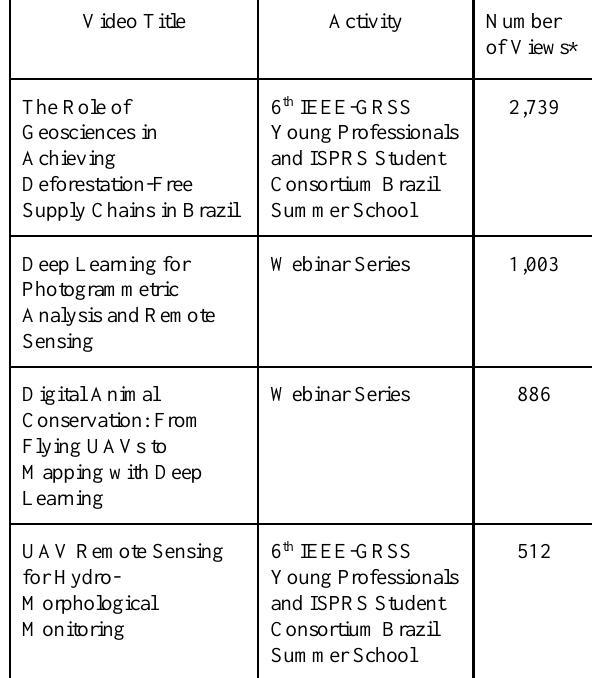
Table 1. The top five most viewed videos on the ISPRS SC YouTube